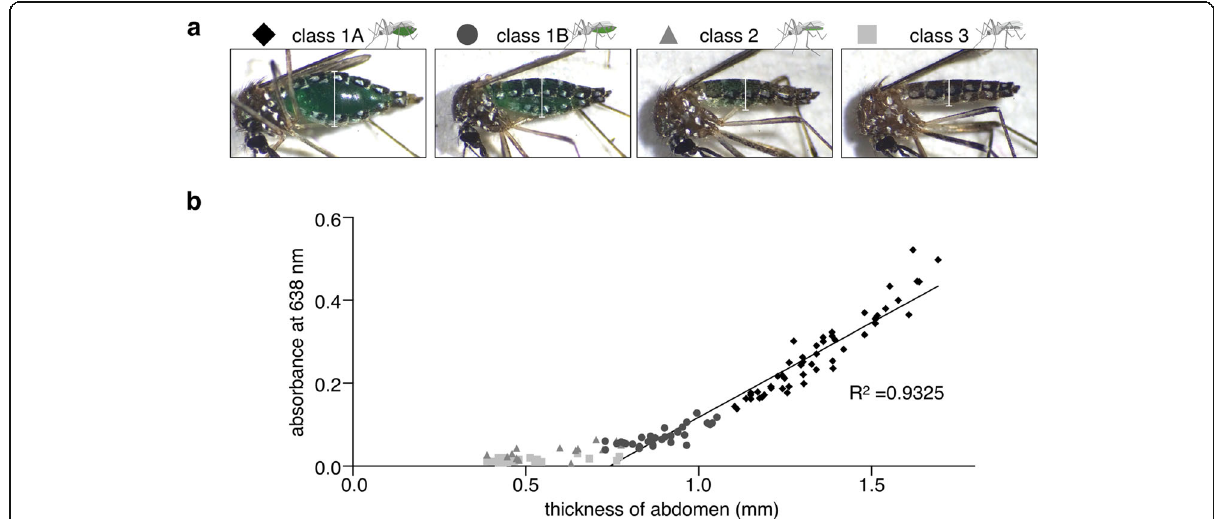
Fig. 4 Estimation of volume of ATP solution ingested by mosquitoes using the naked eye. a Classification of mosquitoes that sucked green- colored 0.1 mM ATP solution. Class 1A (diamond), fully engorged abdomen; class 1B (circle), partially swollen abdomen; class 2 (triangle), colored abdomen with intact shape; and class 3 (square), abdomen with intact shape and no color observed. White vertical lines on each image indicate the thicknesses of abdomens. b A scatter plot indicates a linear relationship between the two variables, absorbance at 638 nm of the mosquito extract and the thicknesses of mosquito abdomens. Simple linear regression analysis was performed using data of class 1A and 1B mosquitoes ( R 2 =